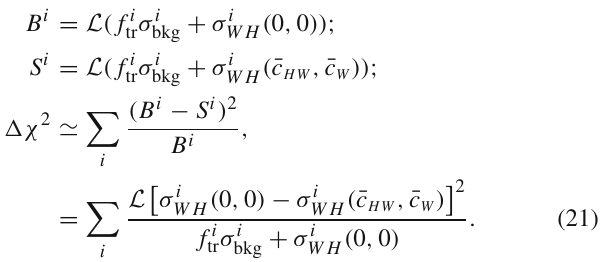
We consider three different choices for the integrated luminosities, and over- the dashed lines indicate the previously obtained marginalised limits on T the Wilson coefficients from the global fit of Refs.